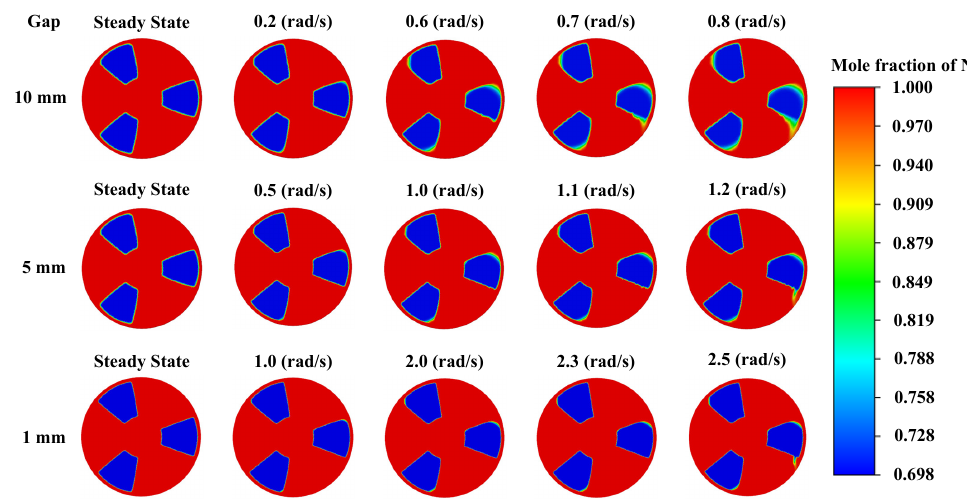
Figure 9. Contours of the mole fraction of nitrogen on the plate rotating clockwise in R2 with gap distances of 10 mm, 5 mm, and 1 mm in various angular velocities, which depict the invasion of N 2 into the reaction zones and reagent runoff into the purge zones at higher rotation